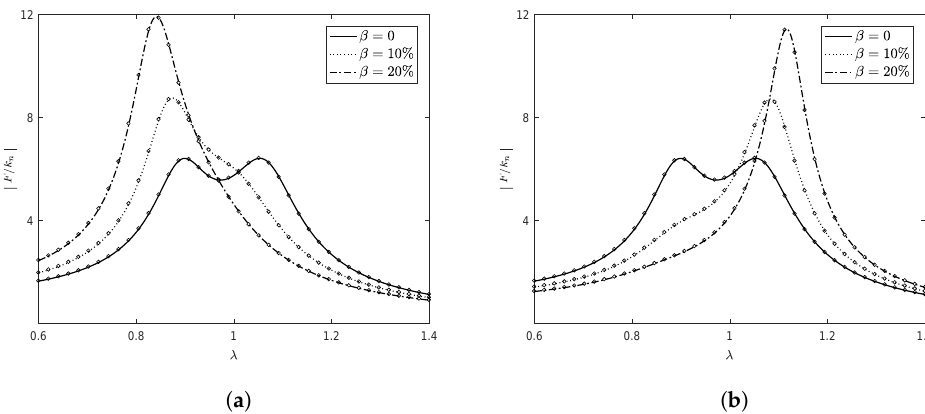
Figure 7. Comparison of frequency responses of an uncertain primary system controlled by means of a TMD corresponding to three levels of stiffness uncertainty: ( a ) δ = − β ; ( b ) δ = + β . The parameters of the TMD were optimized either via the tuning strategy from Ref. [36] (represented by circle markers) or via the methodology proposed in this paper (marked by lines). The mass ratio was set as µ = 0.05. Solid line: β = 0, dotted line: β = 10%, dash-dotted line: β =